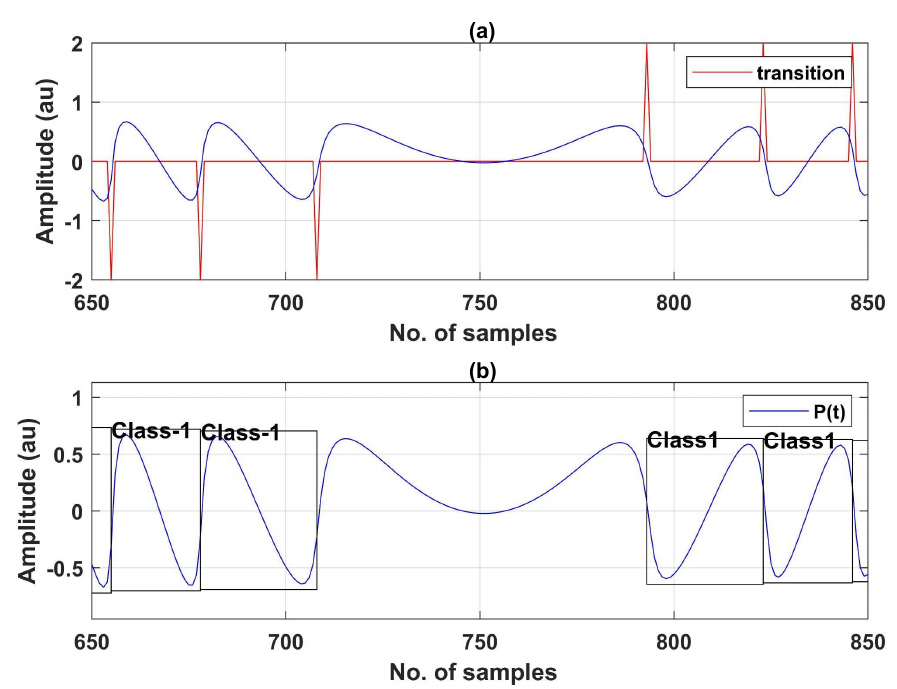
Figure 6. Automated labeling of SMI signals: ( a ) transitions detected on a simulated and noiseless SMI signal. ( b ) Automated placement of bounding box and class label on the SMI